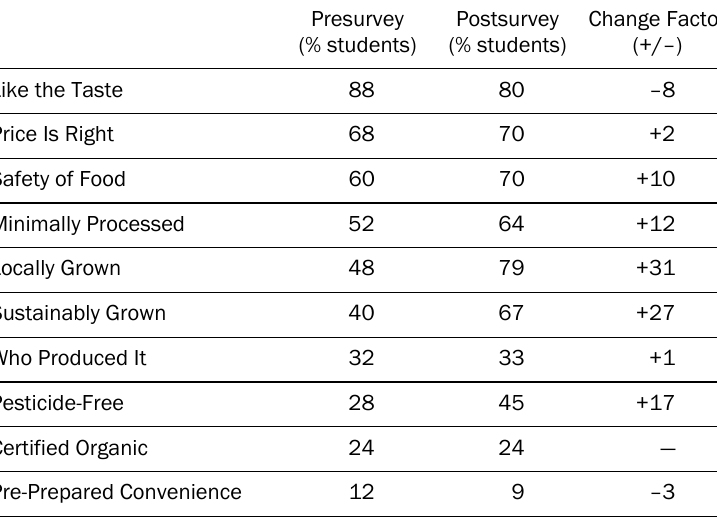
Table 2. Factors Important to Students in Deciding What To